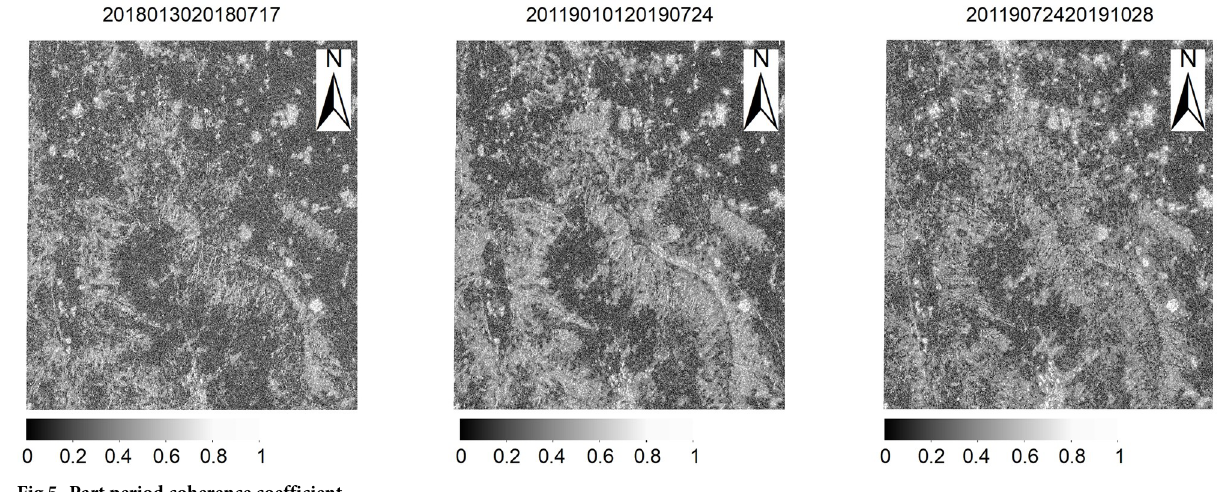
Fig 5. Part period coherence